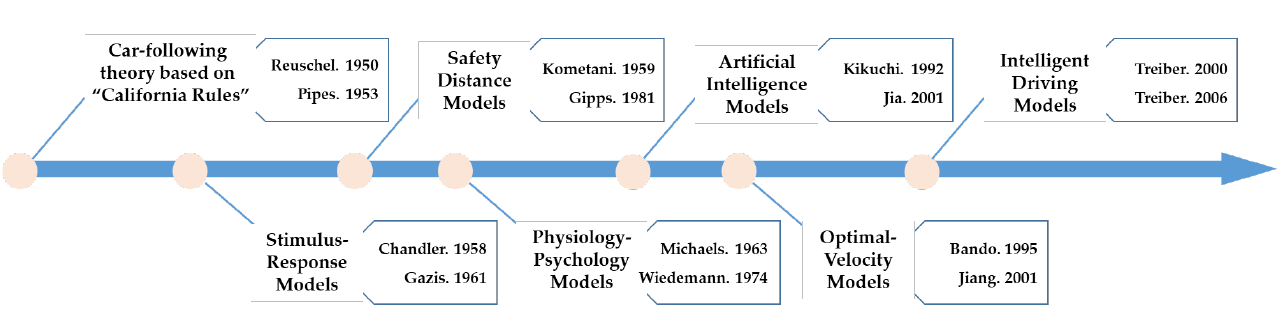
Figure 2. Developing process of the traditional car-following models.